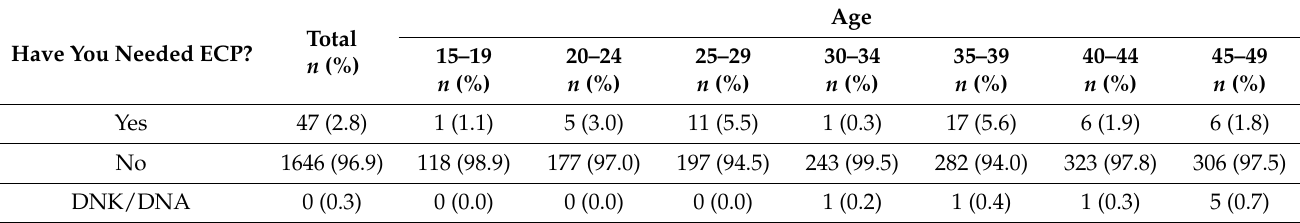
Table 3. Use of the emergency contraception pill (ECP) during